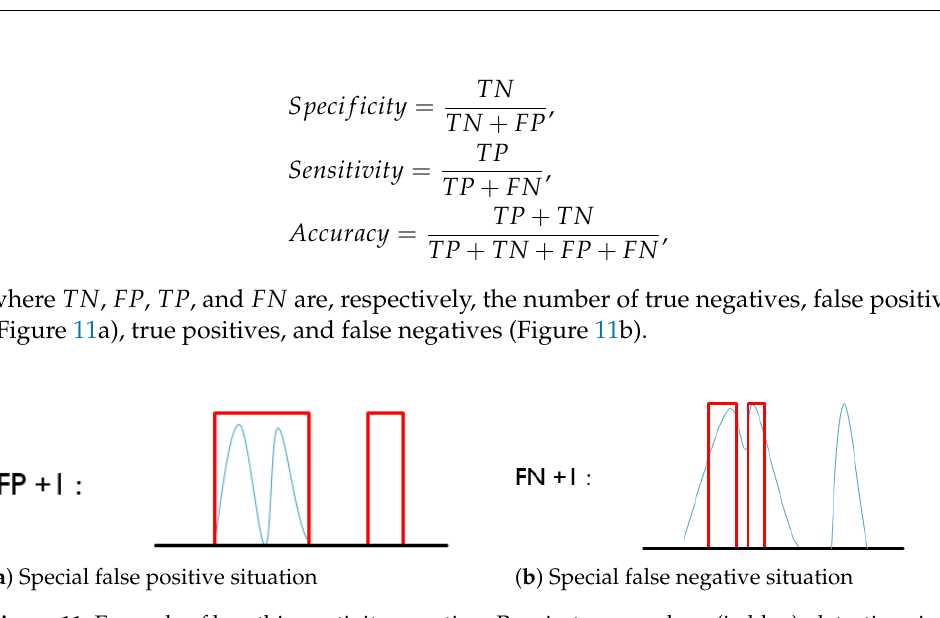
Figure 11. Example of breathing activity counting. Respiratory envelope (in blue), detection signal (in red). ( a ) If two continuous breathing activities are recognized as a single event, or the pause/apnea is detected as one breathing activity, a false positive detection will be reported; ( b ) if one breathing activity is recognized as two events, or one breathing activity is not detected, a false negative detection will be